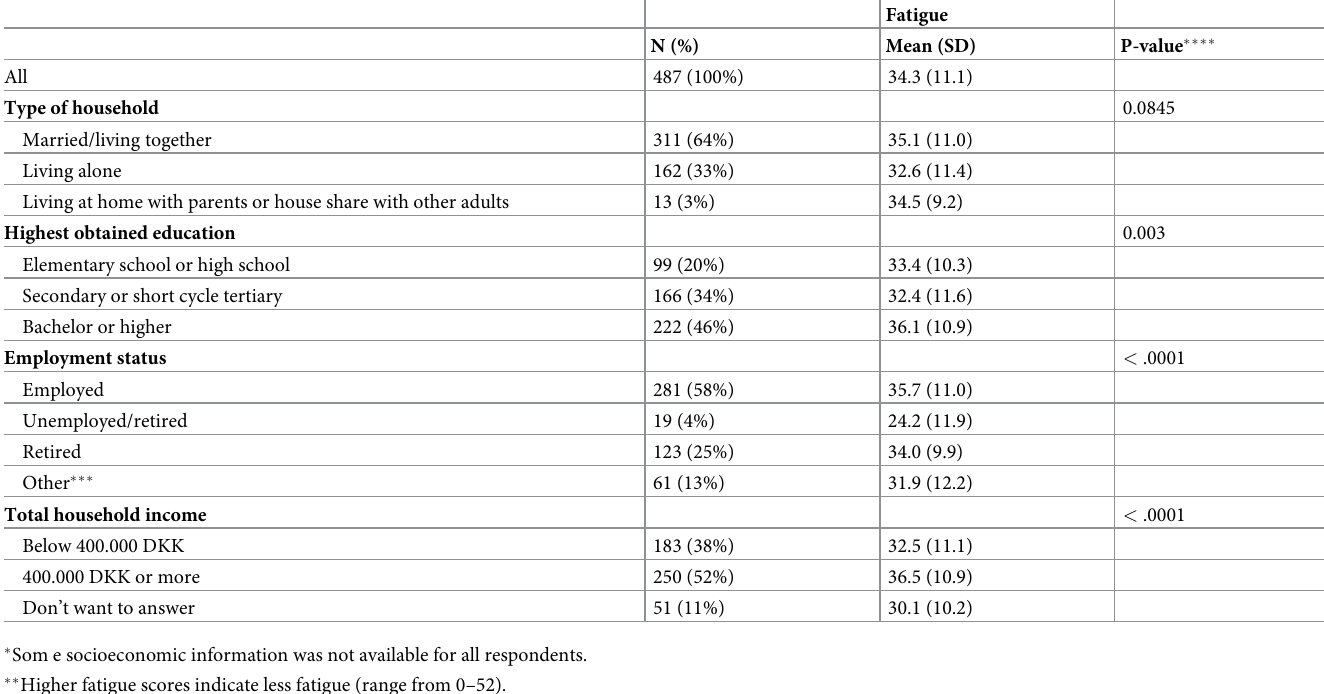
Table 2. Socioeconomic characteristics � of the study population and mean scores of fatigue measured by FACIT-Fatigue �� .